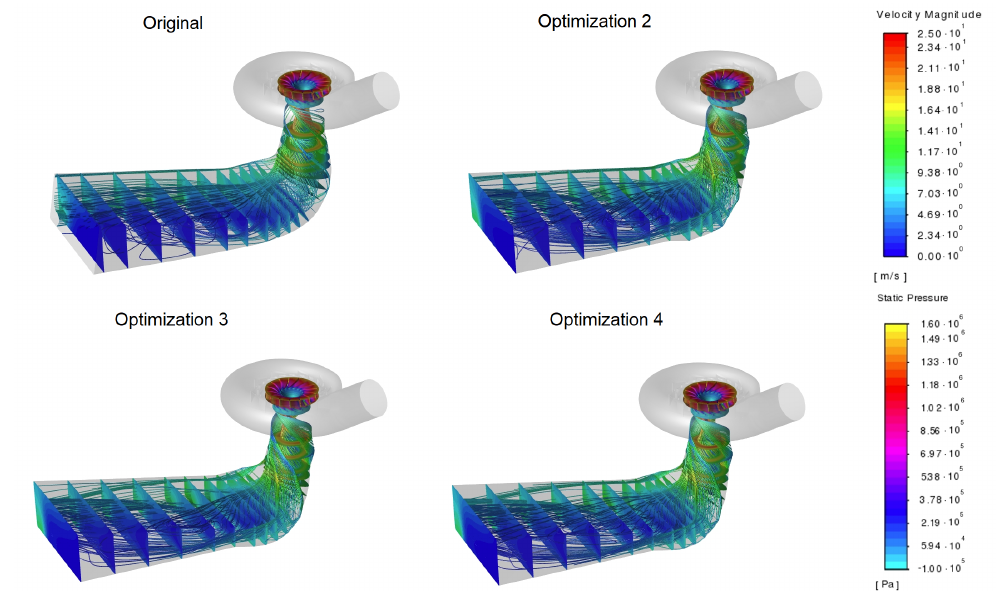
Figure 6. Runner colored to show the static pressure value and the contours of the velocity magnitudes in several draft tube cross-sections, with pathlines starting from the runner outlet for an inlet volume flow rate of 12.8 m 3 /s.